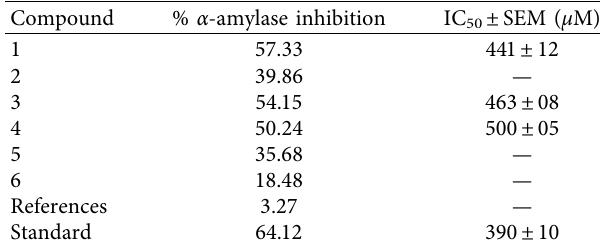
Table 6: Te % α -amylase inhibition activity and IC synthesised metal complexes, moxifoxacin (ligand) taken as ref- erence, and acarbose taken as